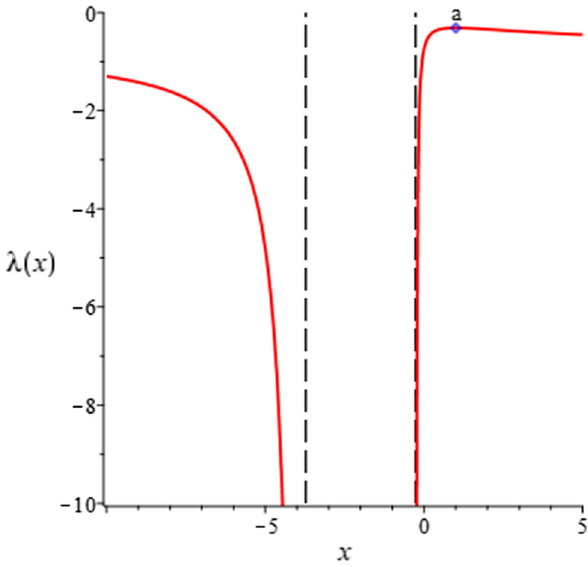
Fig. 6 The function λ( x ) for α < 0 and l = 3